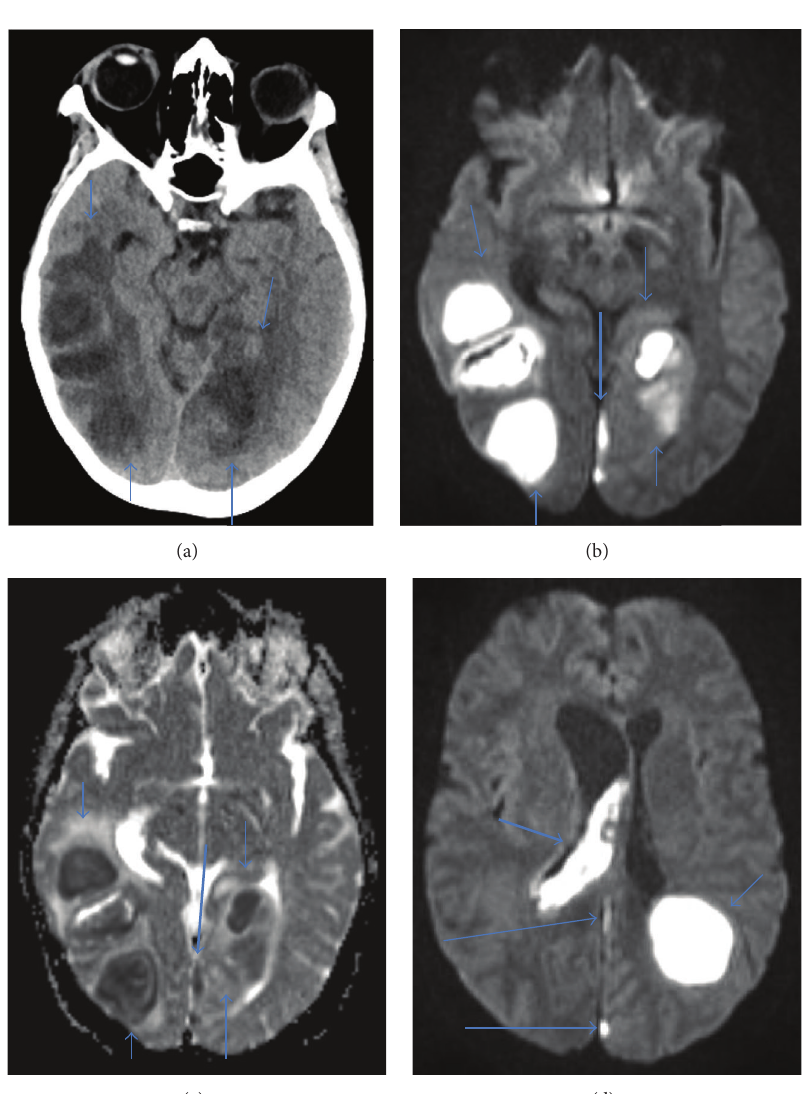
Figure 1: (a) Noncontrast axial CT image, (b) axial diffusion weighted images, (c) axial adjusted diffusion coefficient map that shows bilateral temporal-occipital lobe abscesses (thin arrows) and empyema in the medial left occipital lobe (thick arrow), and (d) axial diffusion weighted image that shows ventriculitis in the right lateral ventricle (short thick arrow), abscess in the left parietal lobe (short thin arrow), and empyema in the posterior falx (long thin arrow) and medial left occipital lobe (long thick